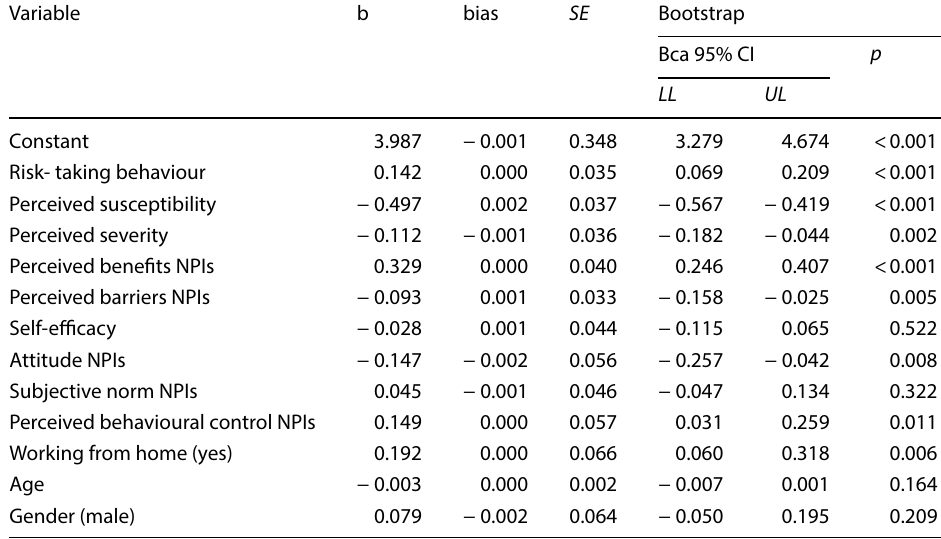
Table 6 Results of the Bootstrapping method